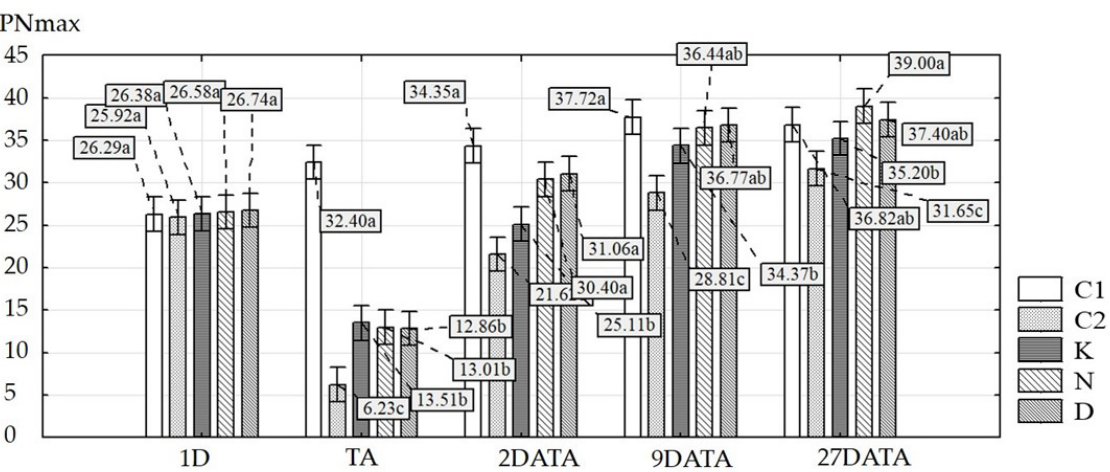
Figure 2. Effects of phytostimulators and time of measurements on maximum net photosynthetic rate of maize leaves. Different treatments and the values followed by the different letter show statistically significant differences within treatments at p < 0.05. Vertical bars mean ± SE, control treatment under normal growth conditions without cold stress (C1), second control treatment under stress growth conditions with cold (C2), Kelpak ® (K), Nano Active ® (N), Dynamic Cresco ® (D), initial measurement before stress (1D), treatments application (TA), 2 days after treatments application (2DATA), 9 days after treatments application (9DATA), 27 days after treatments application (27DATA).